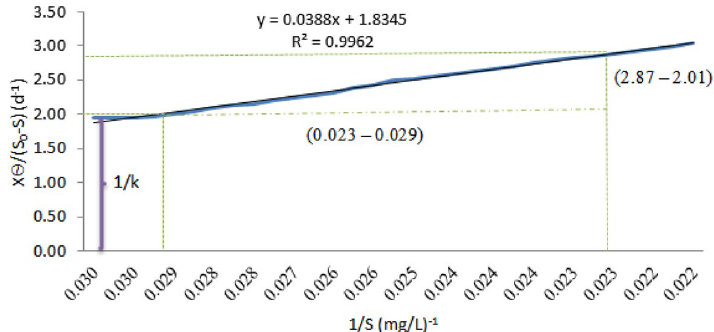
Figure 6. Estimated the k and K s in the use of SMFs on ASM 3.